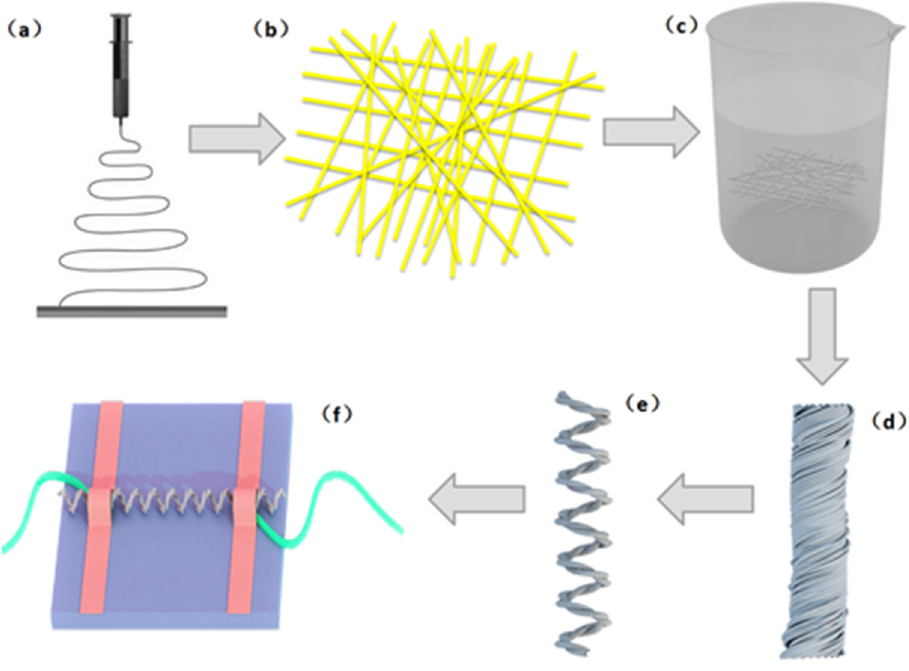
Figure 1. Preparation process of fabricating a thermoplastic polyurethane (TPU) / graphene strain sensor with an intertwined-coil configuration: ( a , b ) electrospinning technique; ( c ) dip-coating technique; ( d , e ) spinning technique; and ( f ) the properties of strain sensor measurement.